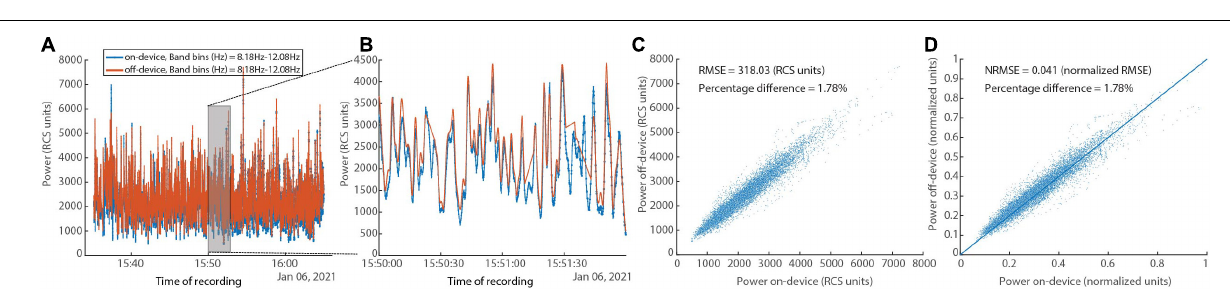
provides a more comprehensive view of the therapy. Our plotting tool allows for easily customized visualization of one or multiple